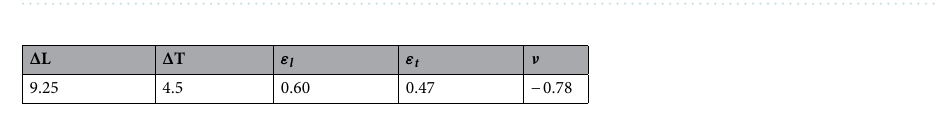
Table 3. Measured displacements, strains and Poisson’s ratio of dry auxetic